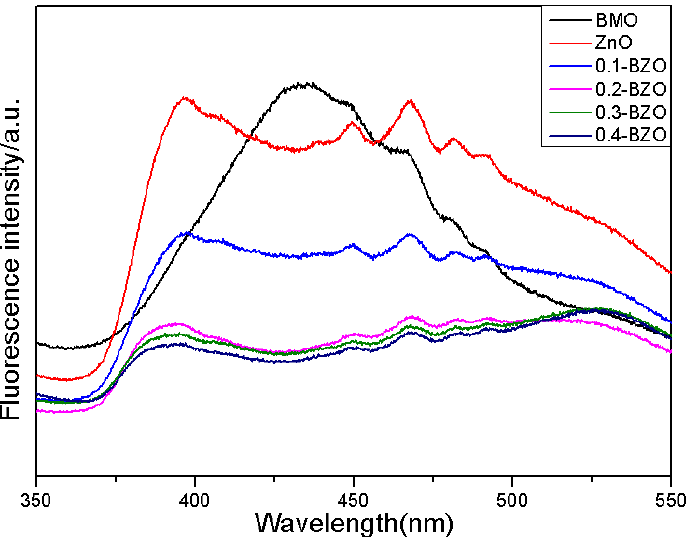
Figure 6. PL spectra of BMO, ZnO and X-BZO at room temperature (the excitation wavelength was 330 nm).